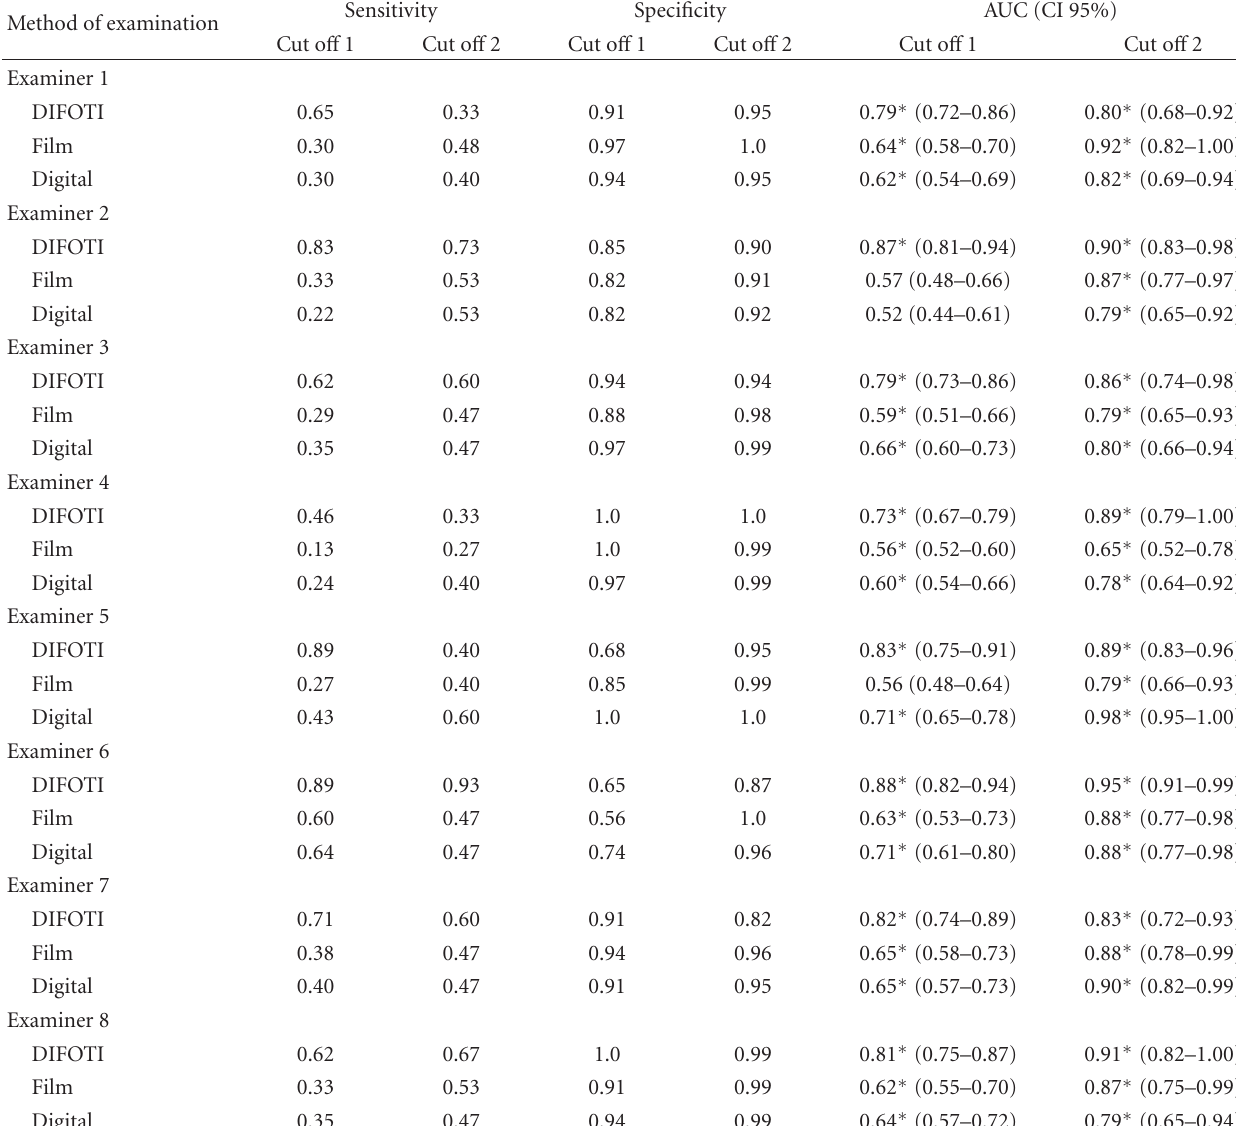
Table 2: Examiner performance in detecting approximal caries lesions at two di ff erent diagnostic thresholds, expressed as sensitivity, specificity and AUC: area under the receiver operating characteristic (ROC) curve. Confidence interval of 95% is presented in brackets (CI 95%).